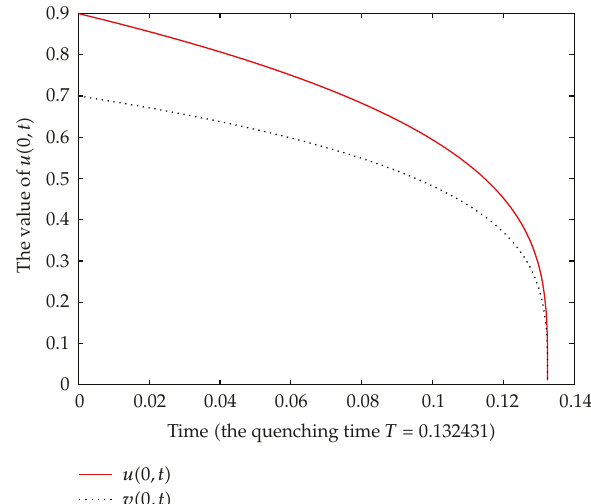
Figure 2: Evolution at the point x 0 (cid:3) 0 of the solution (cid:5) p 1 (cid:3) 0 . 5 , q 2 (cid:3) 0 . 6 , q 1 (cid:3) p 2 (cid:3) 2 (cid:6) .